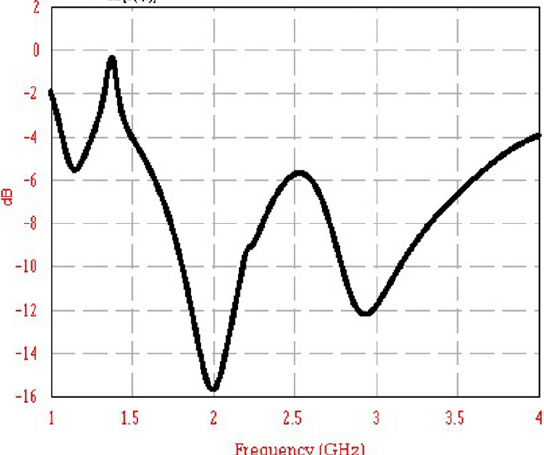
10.76 dBi which is better as found in other conventional is shown in Figure 7 & Figure